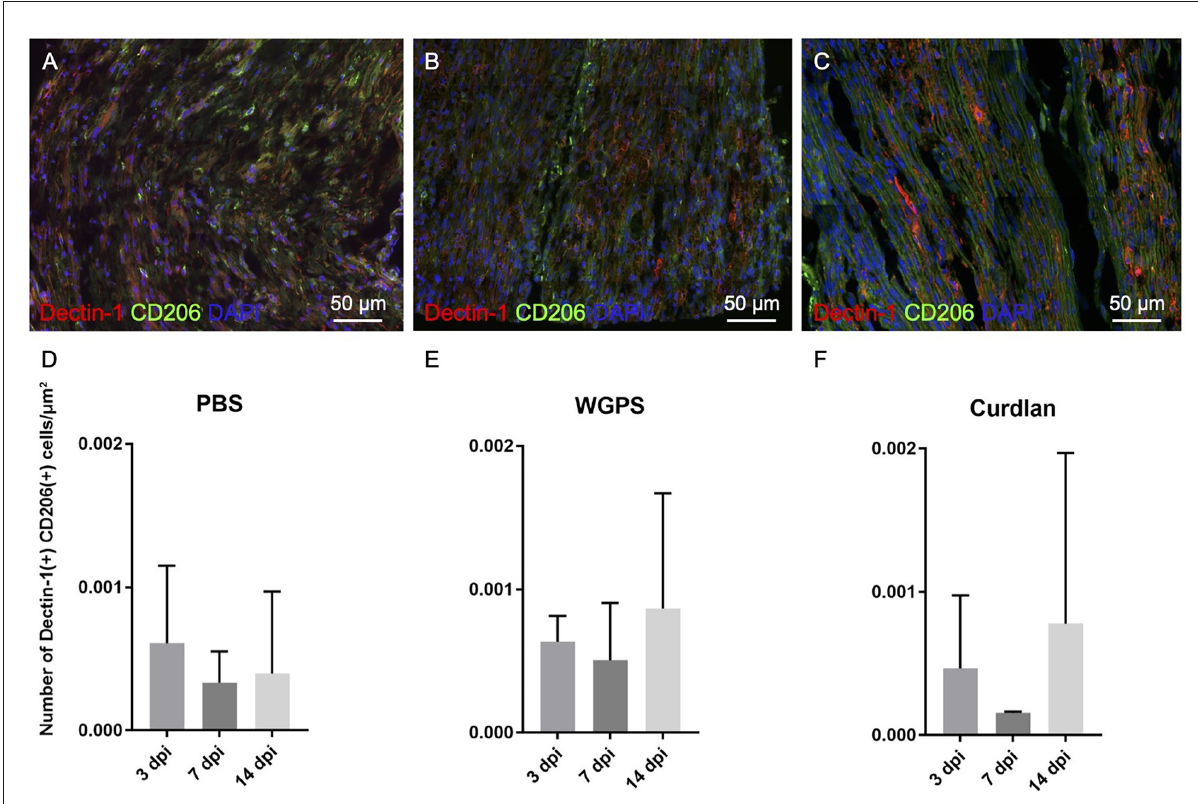
FIGURE9 Analysis of CD206 and Dectin-1 colocalization on crushed sciatic nerves. Longitudinal sections of the ipsilateral sciatic nerve from 500 µ m proximal to 500 µ m distal to the crushed site were stained with anti-Dectin-1 and anti-CD206 antibodies. Dectin-1(+) CD206(+) cells were identified for analysis. (A–C) Representative figures from (A) crushing injury plus PBS injection 3 days after injury, (B) crushing injury plus PBS injection 7 days after injury, (C) crushing injury plus PBS injection 14 days after injury. (D–F) Quantitative analysis of Dectin-1(+) M2 macrophage density [Dectin-1(+)/CD206(+) cell density] at different time points. There were no difference between the groups. Data are represented as mean ± SD ( n : 3 dpi: PBS = 4, WGPS = 3, curdlan = 4; 7 dpi: PBS = 5, WGPS = 3, curdlan = 3; 14 dpi: PBS = 3, WGPS = 3, curdlan = 3; 14 dpi: PBS = 3, WGPS = 3, curdlan = 3).